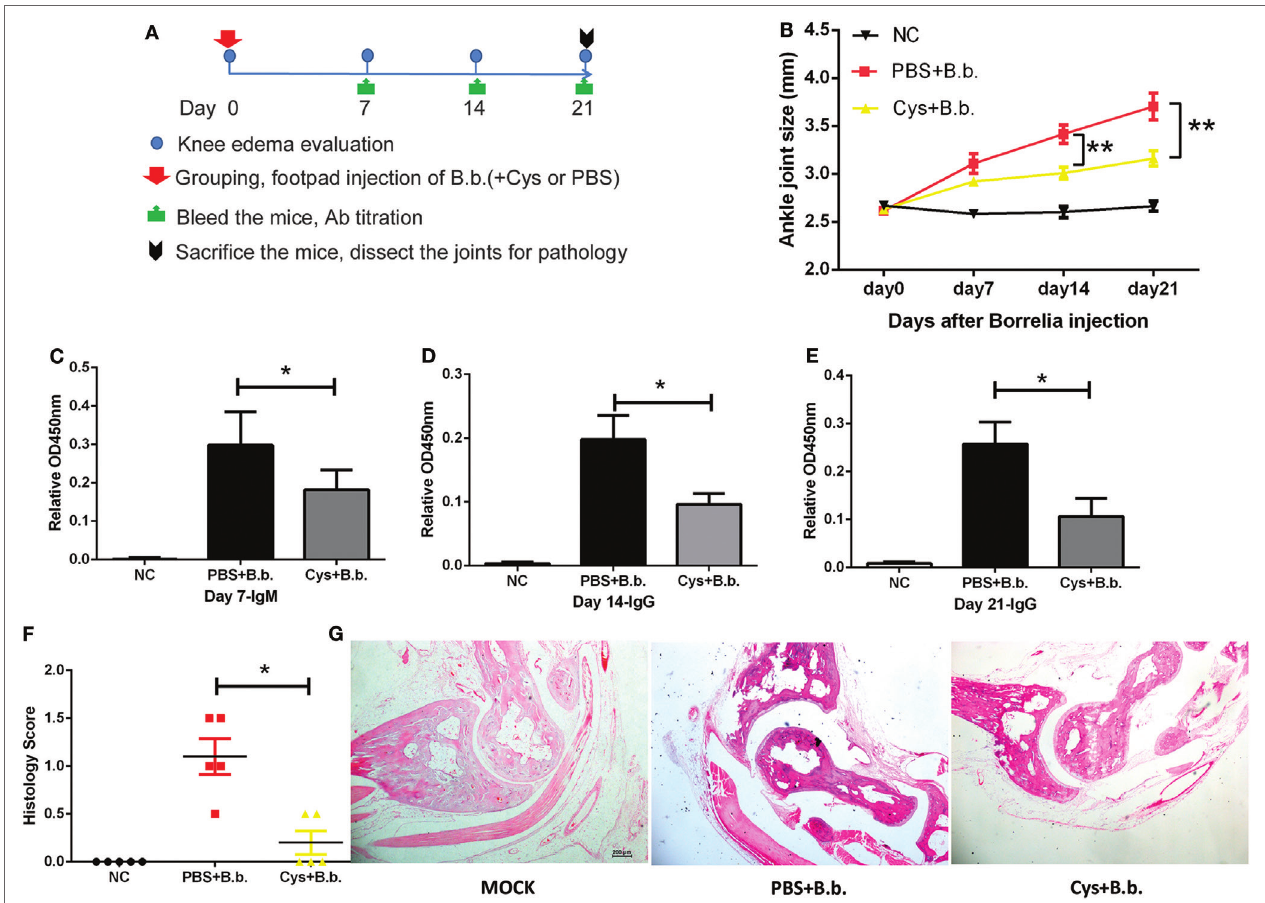
FigUre 6 | DsCystatin relieves Borrelia Burgdorferi -induced joint inflammation in C3H/HeJ mice. (a) The protocol of DsCystatin treatment on B. burgdorferi - induced joint inflammation. (B) DsCystatin reduced the size of ankle joints after B. burgdorferi infection compared with control mice. The number of animals per group is five in each experiment. Results are expressed as mean ± SEM of ankle joint thickness, n = 5. ** p < 0.01 compared to PBS group (multiple t -test). The representative results from three independent experiments are shown. (c–e) Antibody response decreased in DsCystatin-treated mice compared with controls: (c) B. burgdorferi specific IgM level at Day 7 post infection. (D,e) B. burgdorferi -specific IgG level at Day14 (D) and Day 21 (e) post infection. Results are expressed as mean + SEM value of antibody titers from five mice. * p < 0.05 ( t -test). The representative results from three independent experiments are shown. (F) Arthritis score of B. burgdorferi -infected mice treated with DsCystatin or PBS control. Results are expressed as mean ± SEM of arthritis scores of five mice. * p < 0.05 ( t -test). The representative results from three independent experiments are shown. (g) H&E staining of joint sections from B. burgdorferi -infected mice at Day 21 post infection. The representative results from three independent experiments are